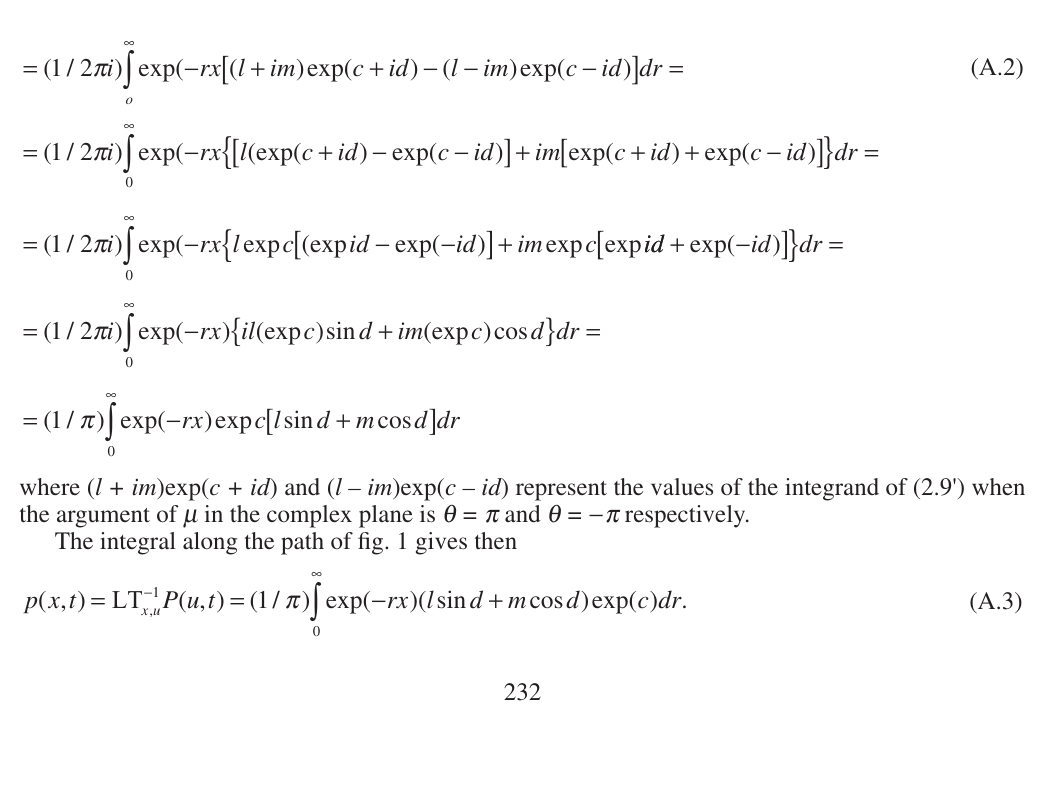
− 1 in eq. (2.9'). b and iu are the real and imaginary parts u x ,